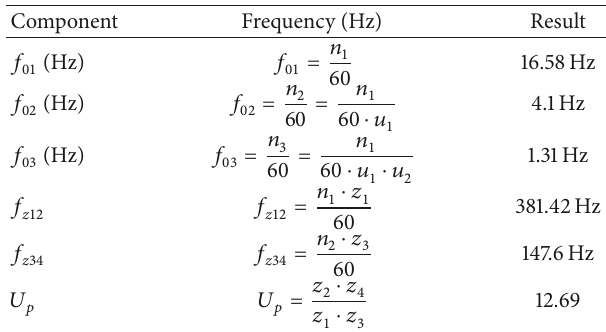
Table 1: Characteristic